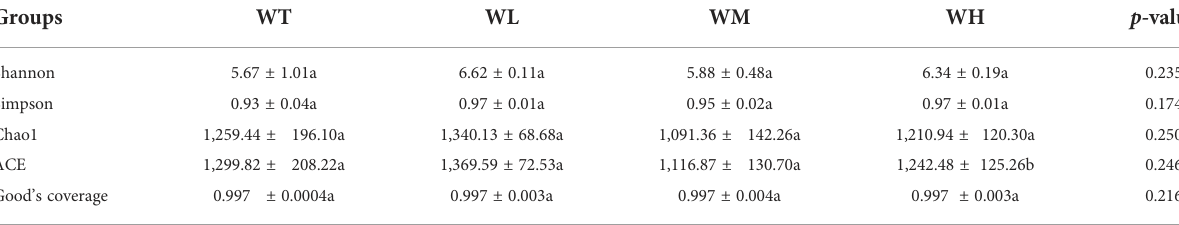
Good ’ s coverage The results shown are the mean ± standard error (M ± SE). Different letters represent signi fi cant differences (p< 0.05). Values not sharing the same lowercase letters differed signi fi cantly. WT, control group; WL, low-concentration group; WM, middle-concentration group; WH, high-concentration